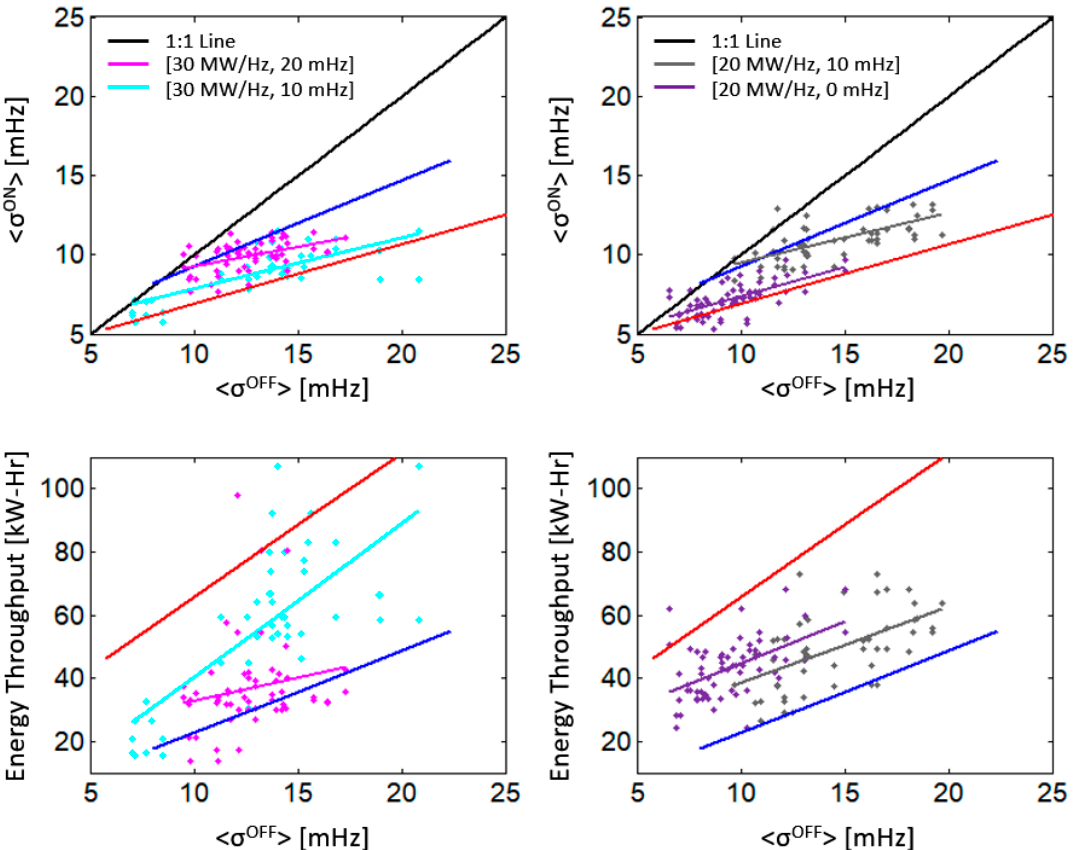
Figure 7. Top Left : Grid frequency variability results for a gain of 30 MW/Hz with the magenta lines and dots showing results for a deadband of 20 mHz and the cyan lines and dots showing results for a deadband of 10 mHz. Bottom Left : Energy throughput results for the same two cases shown immediately above. Top Right : Grid frequency variability results for a gain of 20 MW/Hz with the gray lines and dots showing results for a deadband of 10 mHz and the purple lines and dots showing results for a deadband of 0 mHz. Bottom Right : Energy throughput results for the same two cases shown immediately above.